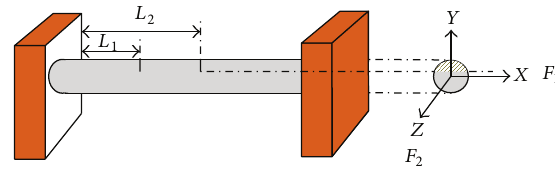
Figure 1: Schematic diagram for multiple crack shafts.